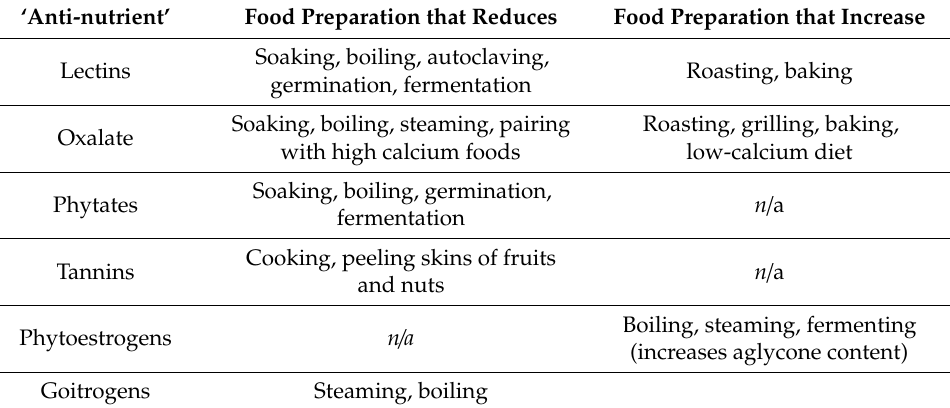
Table 2. Preparation tips for reducing